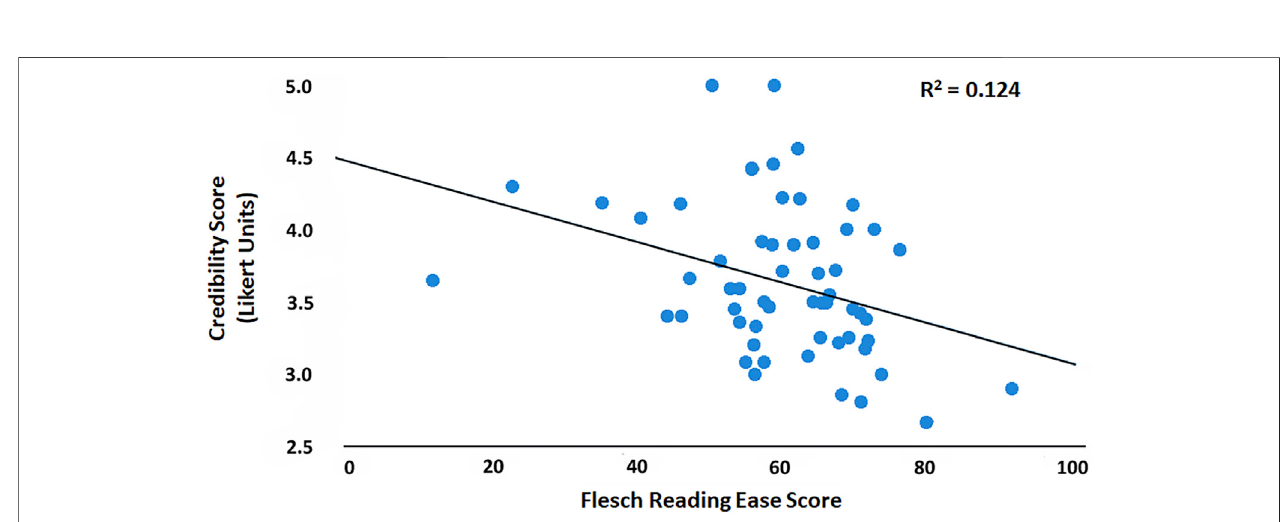
FIGURE2| AudiencescoringofCredibility( “ Thesubjectisrelevanttomyinterests ” )declinesastranscriptReadingEasescoresgoup.ThehighertheReadingEase score, the easier the text of the transcript is to read, i.e., the words and sentence structure are less complex.